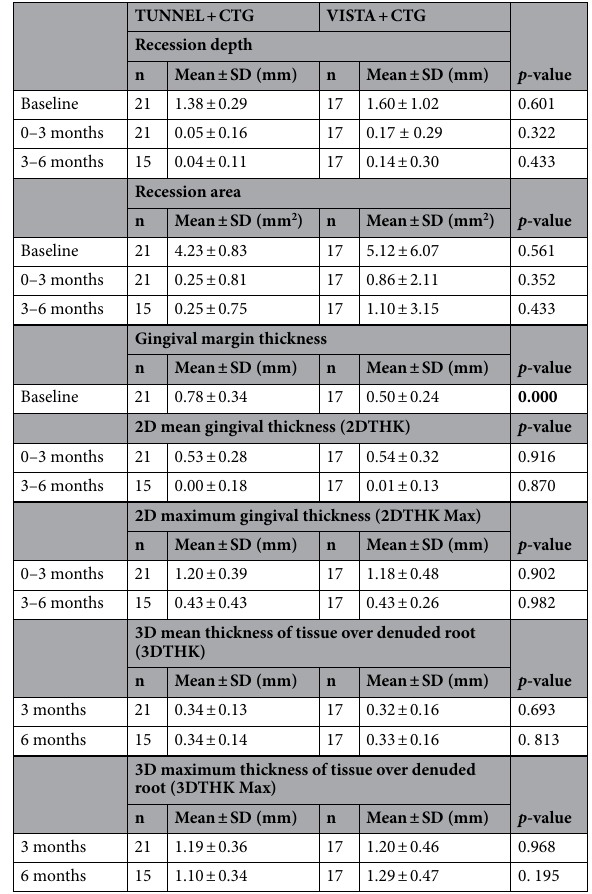
Table 3. Recession depth and marginal soft-tissue thickness (2DTHK, 2DTHK Max, 3DTHK, 3DTHK Max mm) at baseline, 3 months, and 6 months.